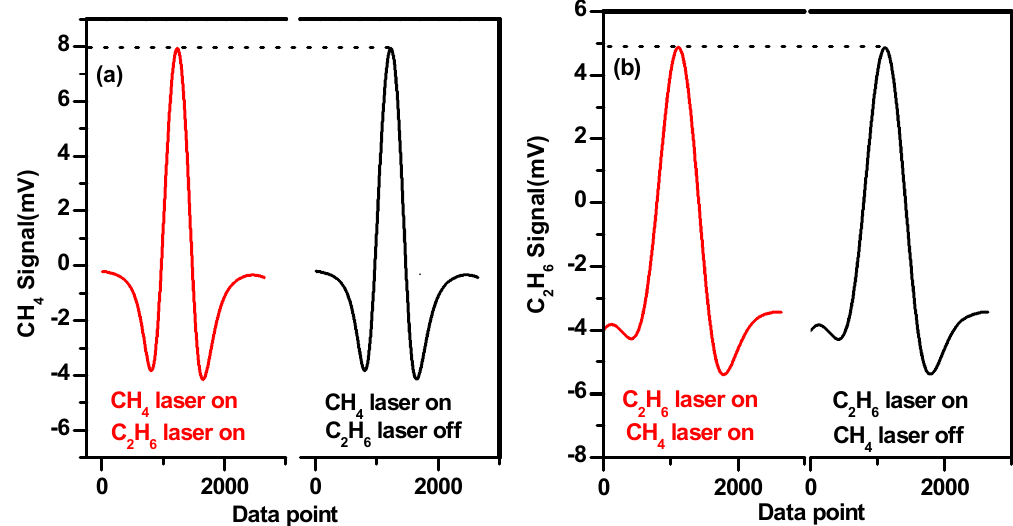
Figure 9. Comparison of the second harmonic signal amplitudes with two lasers on and only one laser on. ( a ) Methane detection and ( b ) ethane detection.